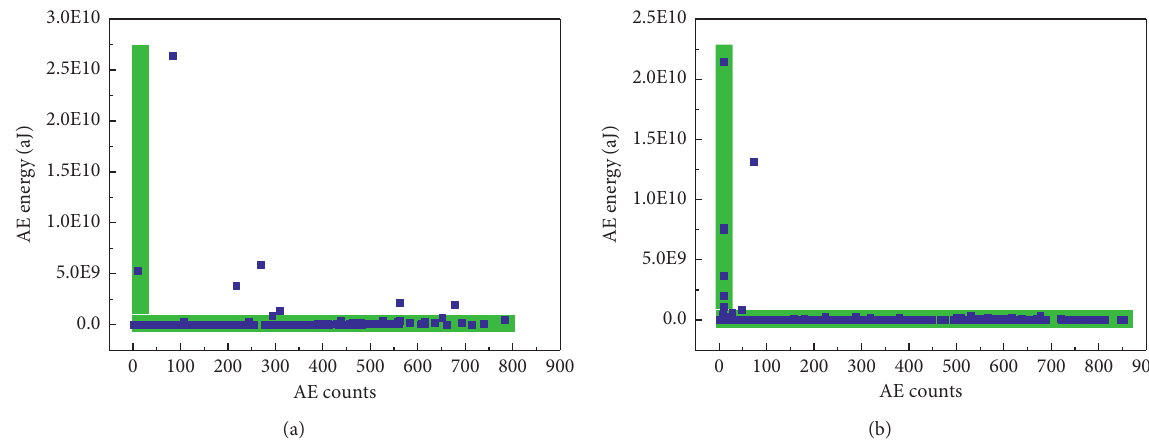
Figure 9: AE count-energy correlation of the intact specimen (a) and the intact specimen containing an opening